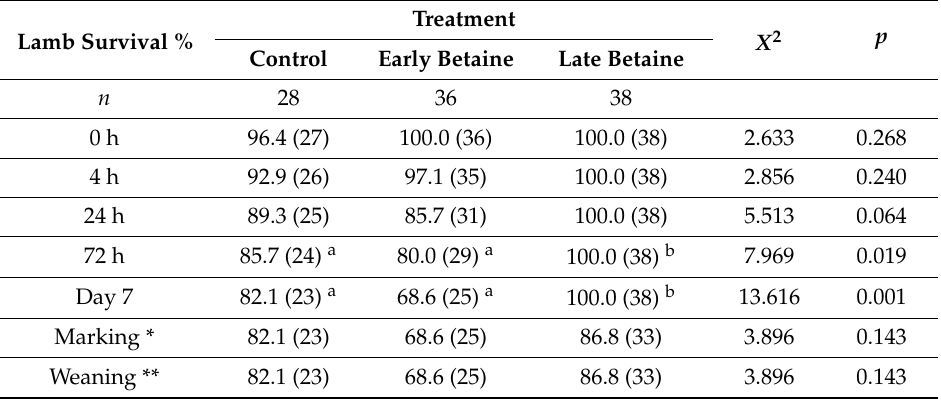
Table 7. Cumulative survival from birth to weaning. Numbers in parentheses indicate the number of alive lambs within each individual treatment. Values with differing superscripts vary significantly ( p < 0.05). Treatment Lamb Survival % X